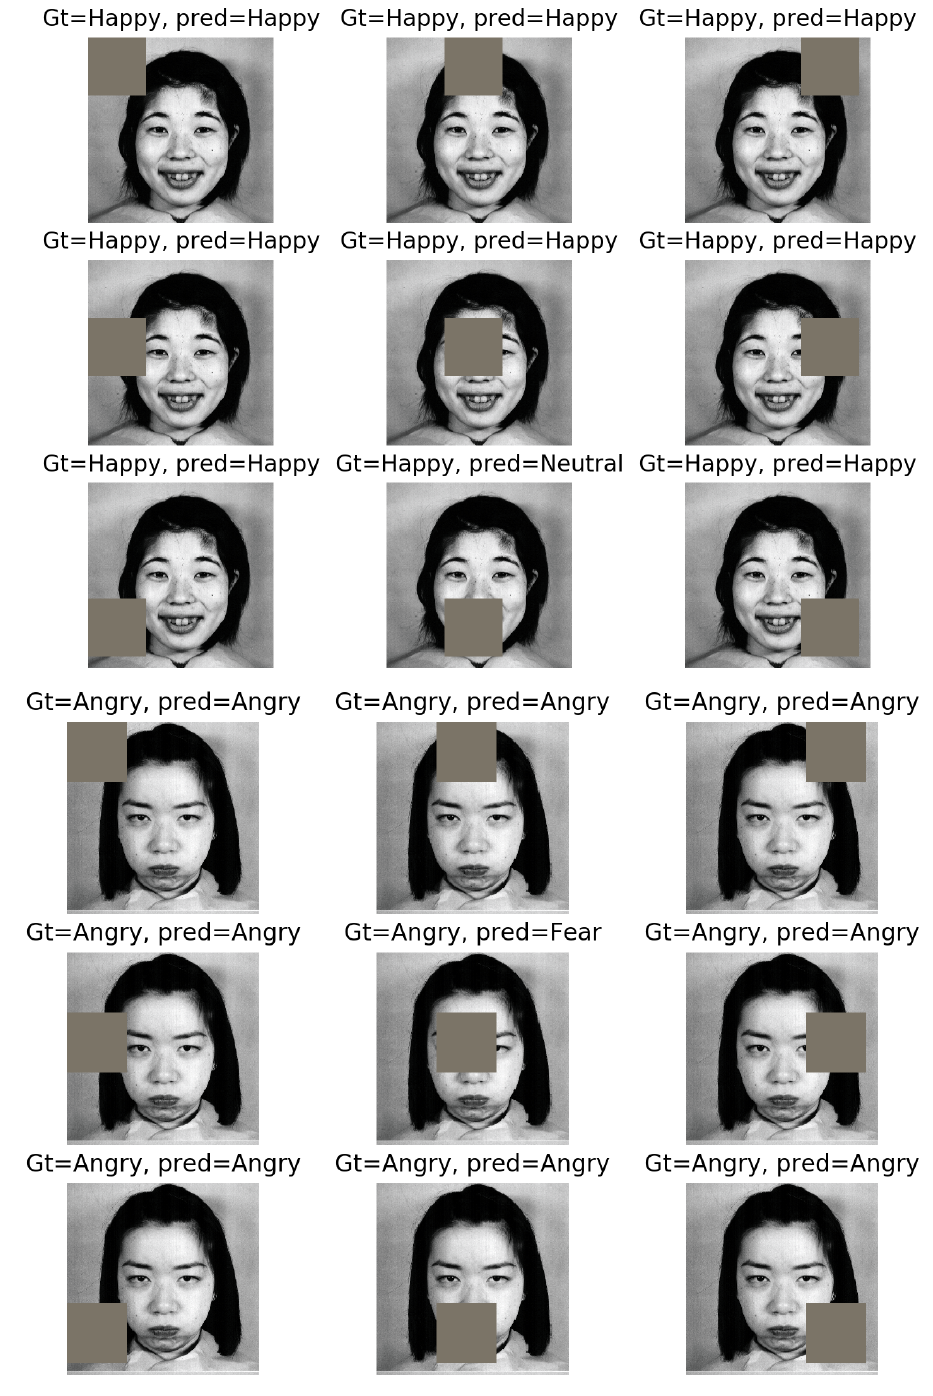
Figure 11. The impact of zeroing out different image parts on the model prediction for a happy face ( the top three rows ) and an angry face ( the bottom three rows